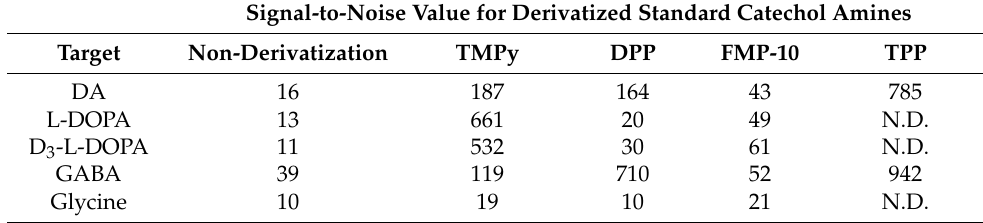
Table 1. Comparison of derivatization reagents for reactive efficiency to target molecules. Signal-to-Noise Value for Derivatized Standard Catechol